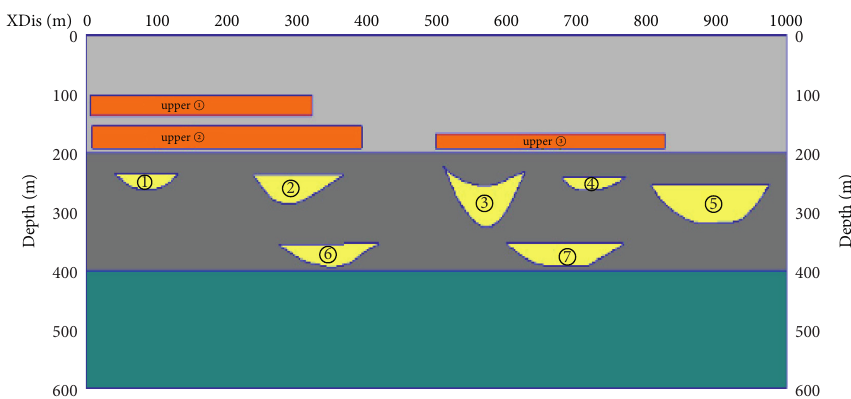
Figure 2: 2D channel geological model with upper interference.